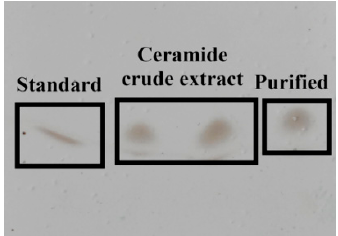
Figure 4. TLC chromatograms of sea red rice bran crude and purified extracts; a commercial rice bran Cer standard was used as a reference standard.